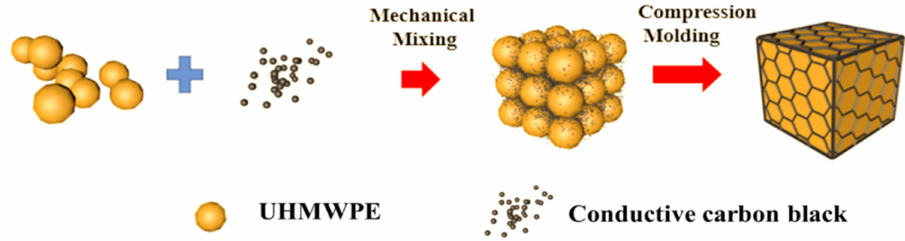
Figure 1. Preparation schematic illustration of segregated UHMWPE/CCB